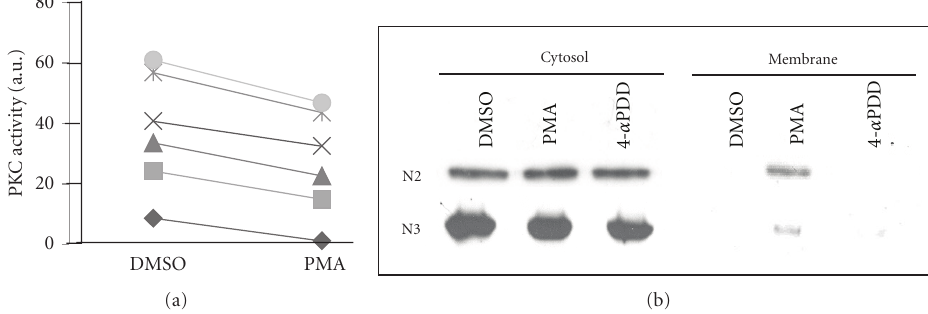
Figure 2: Modulation of PKC α localization and activity upon PMA treatment. (a) Activity of PKC in the presence of Ca 2+ and lipid shows 10–30% reduction in PMA-treated group. Units of activity (a.u.) are arbitrary values assigned by the graphic tool. (b) Western blots of erythrocyte cytosolic and membrane proteins stained with anti-PKC α antibody (represented by N 2 and N 3) show a signal around 77 kDa in the cytosol of all treatment groups but in the membrane fractions of only the PMA-treated erythrocytes.